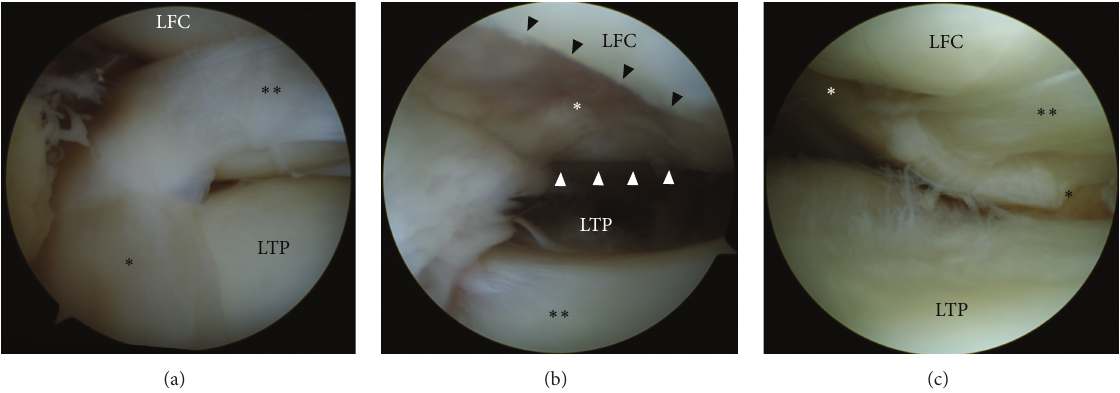
Figure2:Arthroscopicfindingsoftherightkneejoint.(a)Theanteriorlydislocatedmiddlesegmentofthelateralmeniscus(doubleasterisks). The asterisk indicates the anterior horn of the lateral meniscus, which is located in the normal position. (b) An osteochondral defect (asterisk) on the lateral femoral condyle (LFC). The black arrowheads indicate the anterior margin of the defect, and the white arrowheads indicate the posterior margin. The double asterisks indicate the anteriorly dislocated middle segment of the lateral meniscus. (c) The popliteus tendon (white asterisk) originating from the LFC, running on the articular surface of the lateral tibial plateau (LTP), and continuing to the popliteus muscle (black asterisk). A fibrous band (double asterisks) connects the popliteus tendon to the dislocated posterior horn of the lateral